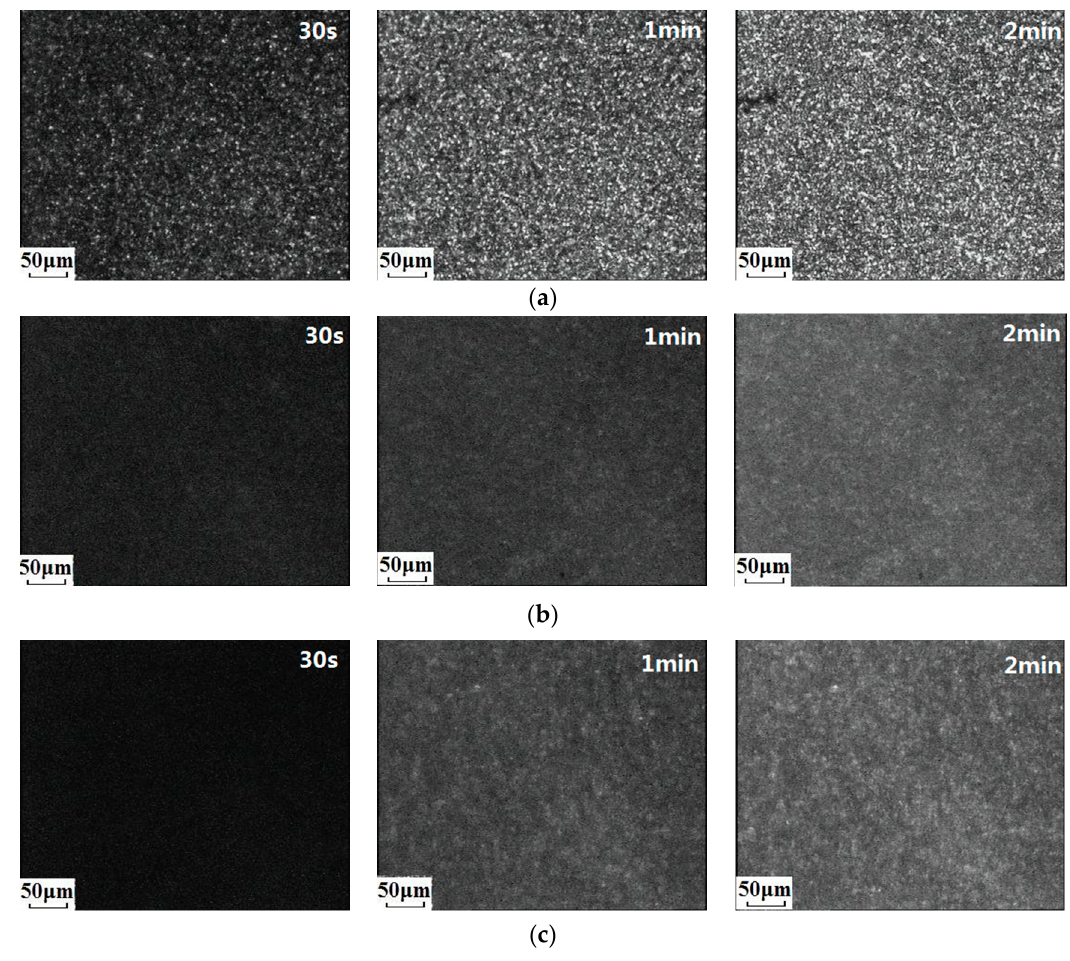
Figure 1. Polarized optical micrographs of ( a ) LCB PP; ( b ) LCB PP/PEOc-80/20; and ( c ) LCB PP/PEOc-40/60 during isothermal crystallization at 140 ◦ C for 30 s, 1 min and 2 min, respectively, left to